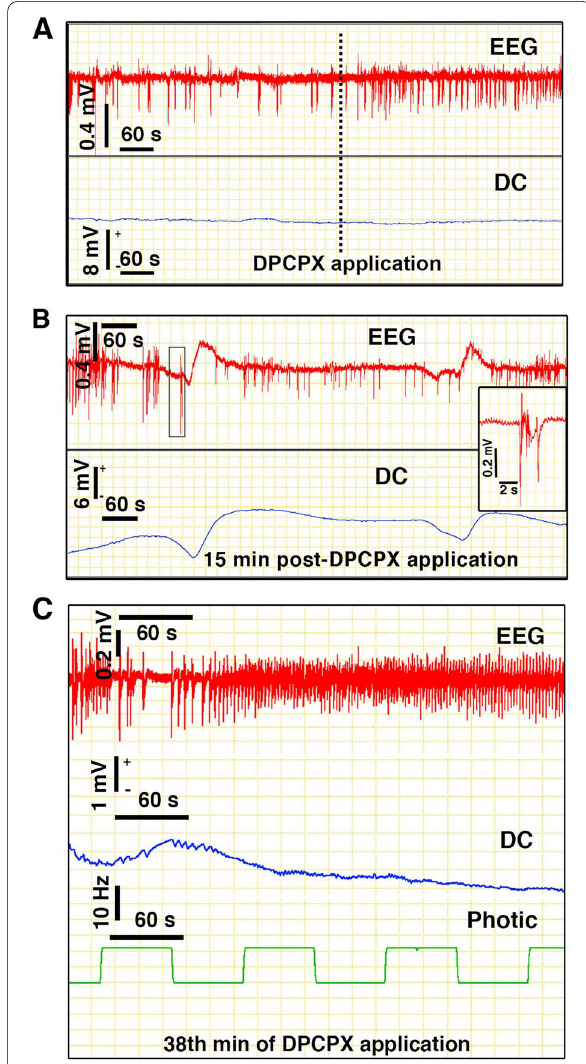
fig. 6 Adenosine generated during synaptic activity may be one of the safety mechanisms preventing CSD ignition. A Epidurally applied selective A1‑receptor antagonist, DPCPX (1 mM) induced irregularly spaced synchronized discharges, indicating that it sufficiently penetrated cortex. B DPCPX applied to the non‑primed occipital cortex caused full‑blown CSDs without stimulation in 4 out of 8 mice, whereas photic stimulation evoked a small‑DC shift during which ongoing EEG activity (except large‑amplitude synchronized discharges) was suppressed in 10 out of 116 photic stimulation periods ( C ). EEG recordings were obtained with